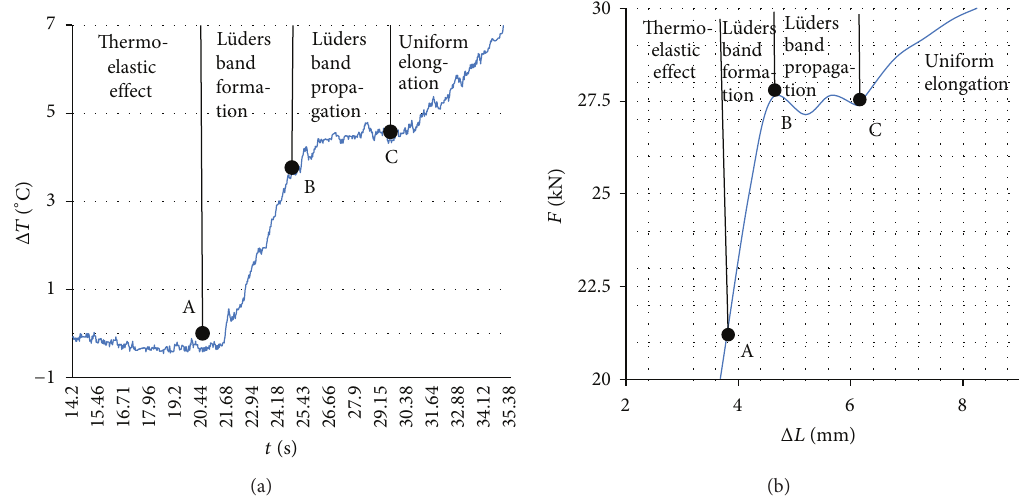
Figure 5: Zones of formation and propagation of L¨uders band. (a) Temporal variations of temperature of niobium microalloyed steel. (b) Load-elongation curve.